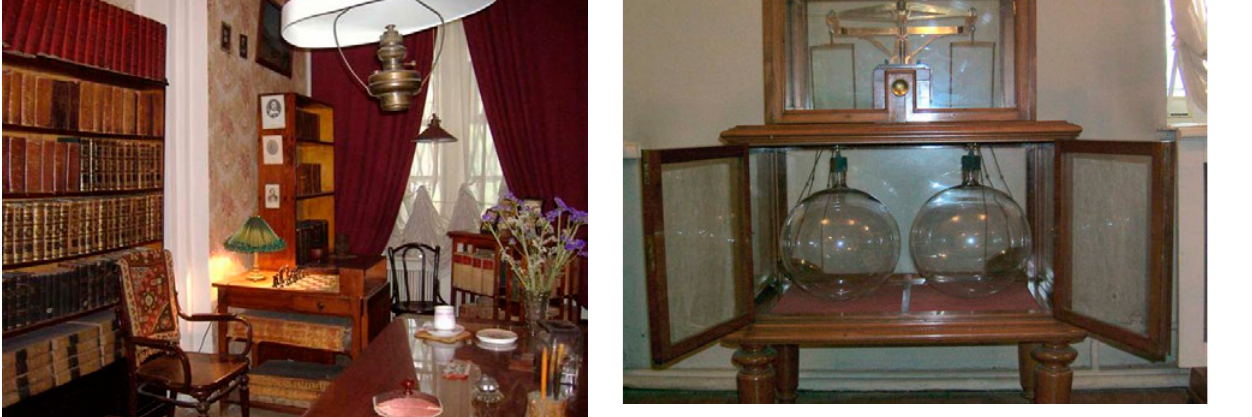
Figure 4. Mendeleev’s Study. Photograph courtesy of Margaret Comaskey.